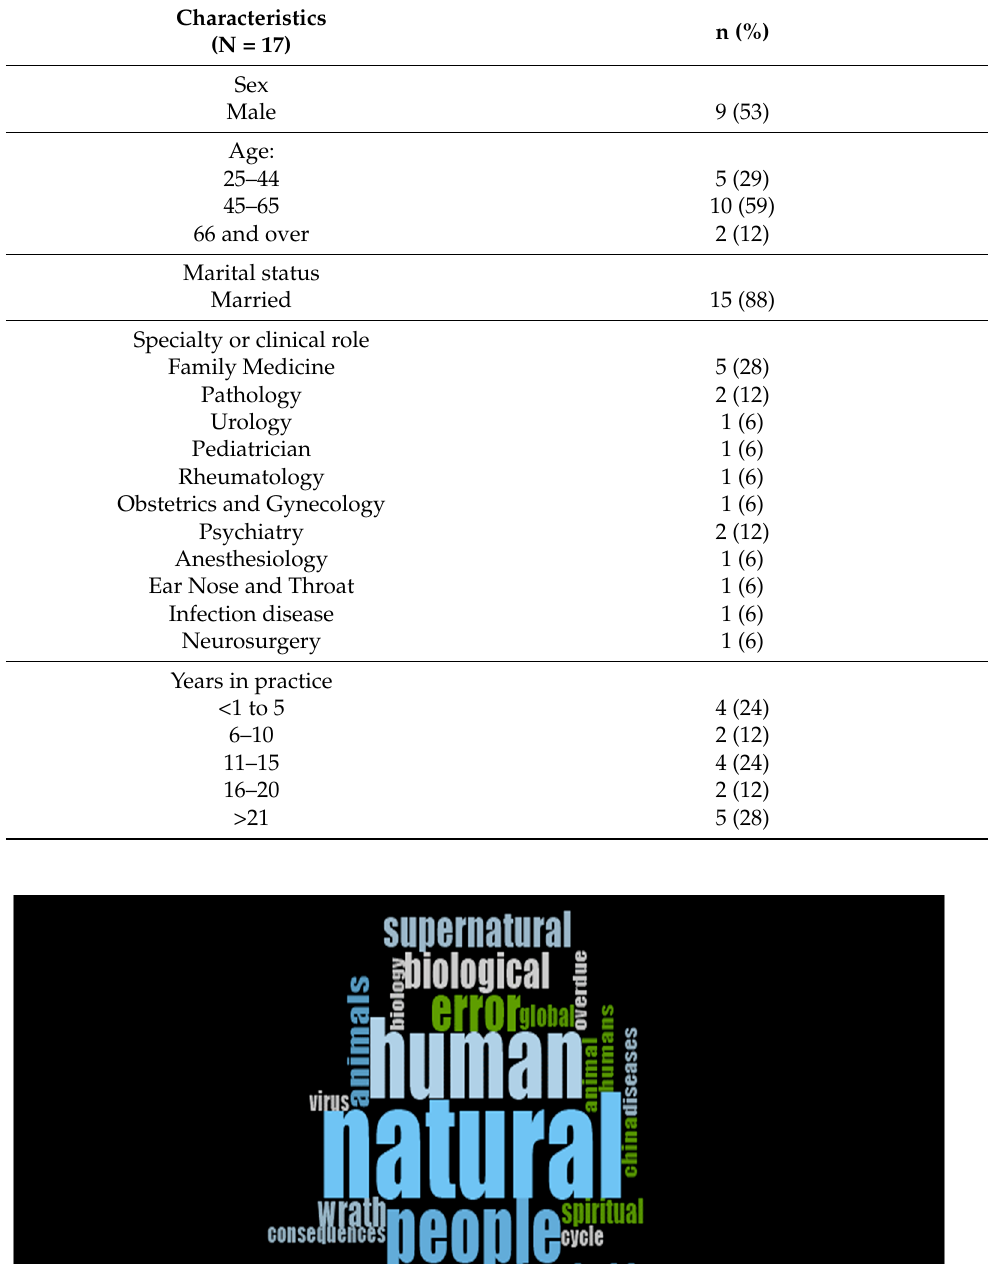
Table 1. Demographic characteristics of the 17 Canadian physicians interviewed during the COVID- 19 pandemic.